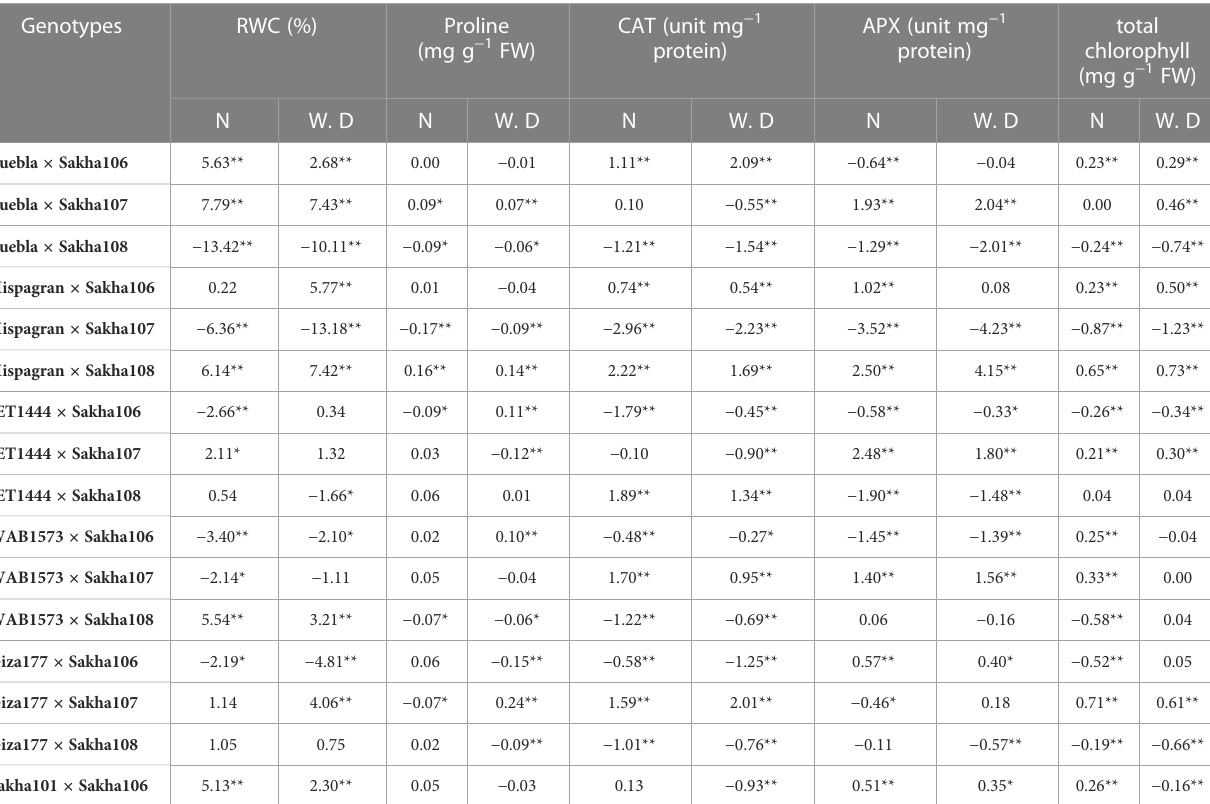
TABLE 5 Estimates of speci fi c combining ability (SCA) effects of the F 1 hybrids for physiological, biochemical, and yield-related (and its components) traits under normal watering and water de fi cit conditions.